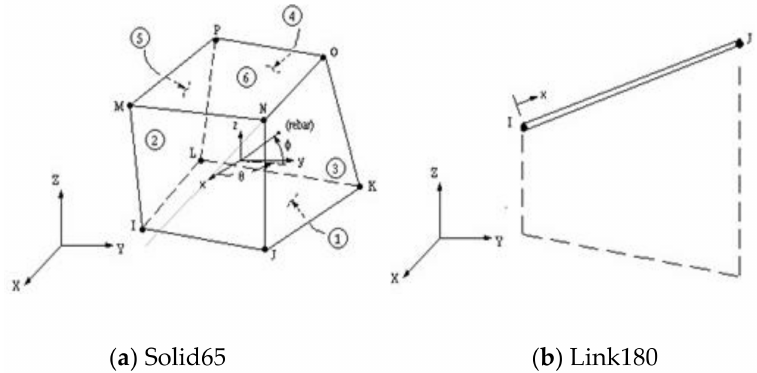
Figure 16. Geometry of element